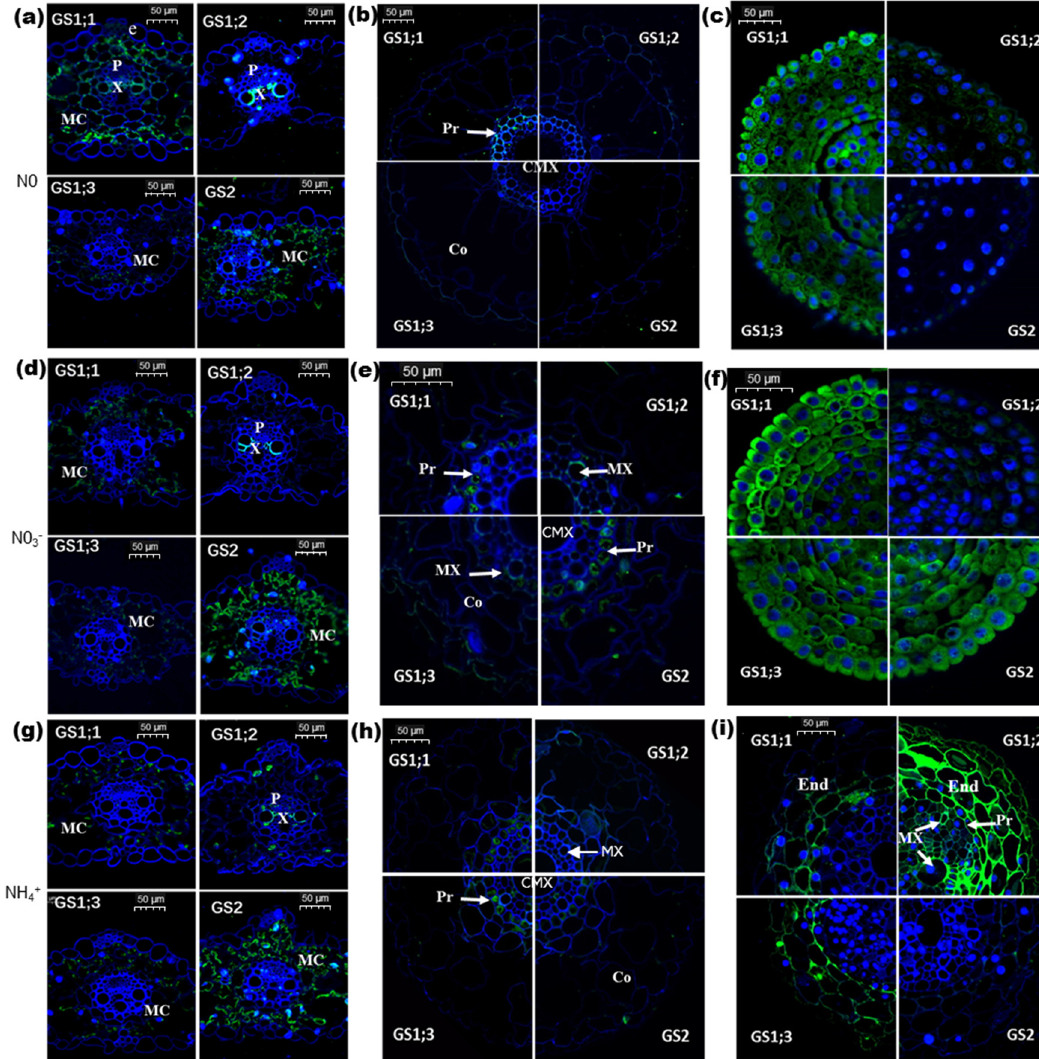
Figure 2. Cellular localization of individual TaGS at protein level. Three-day-old seedlings were separated and grown on a modified Hoagland nutrient solution for 12 days, without N supply (N0), or with 5 mM NO 3 − or 5 mM NH 4+ as the sole N source, and then the top fully expanded leaf, root, and root tips were prepared for immunolocalization. Immunolocalization of TaGS1;1, TaGS1;2, TaGS1;3, and TaGS2 in response to different nitrogen regimes in ( a , d , g ) a transverse section of the leaf, and ( b , e , h ) the maturation zone and ( c , f , i ) meristematic zone of root tissue. Visually, 4 ′ ,6-diamidino-2-phenylindole (DAPI) glowed blue by 330–380 nm UV excitation wavelength and 420 nm emission wavelength; fluorescein isothiocyanate (FITC) glowed green by 465–495 nm excitation wavelength and 515–555 nm emission wavelength. e, epidermis; MX, metaxylem; P, phloem; X, xylem; CMX, central metaxylem; End, endodermis; Pr, pericycle; Co, cortex; and MC, mesophyll cell.